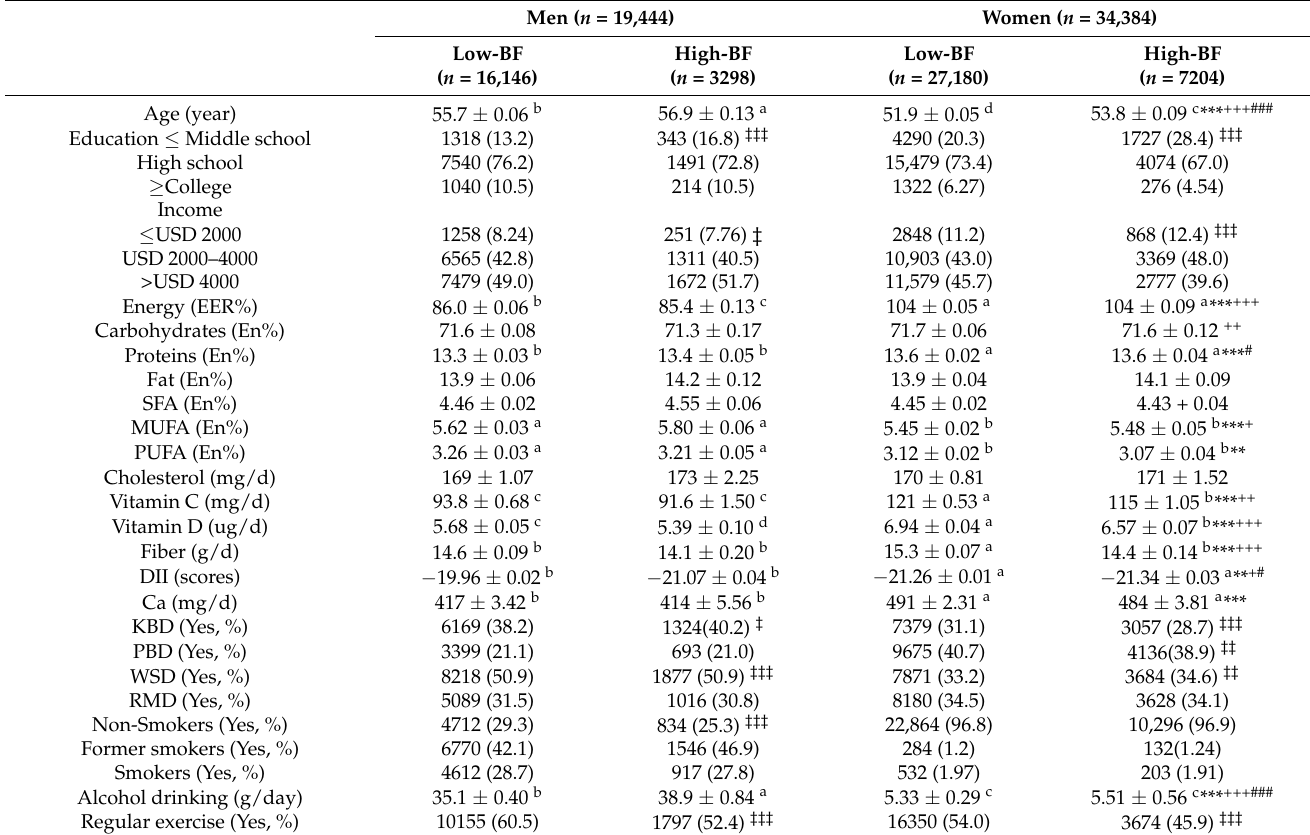
Values represent adjusted means ± standard error for continuous variables and the number and percentages of participants for categorical variables. Adjusted for the covariates including age, BMI, education, income, energy intake, alcohol intake, smoking, and total activity. High body fat (case) was defined as 25% and 30% of body weight for men and women, respectively. EER%, the percentage of energy intake based on estimated